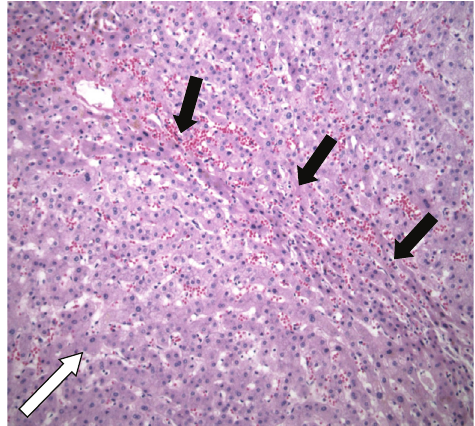
Figure 3: Detail of the intra-operative liver specimen (Case 2) showing nodular regenerative hyperplasia in which a regenerative nodule (white arrow) is bordered by irregular aligned small-sized hepatic trabeculae (black arrows). Hematoxylin and eosin, original magnification